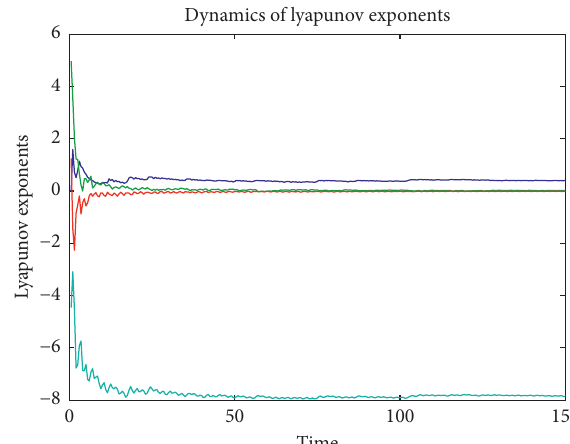
Figure 2: Dynamics of Lyapunov exponents with respect to system